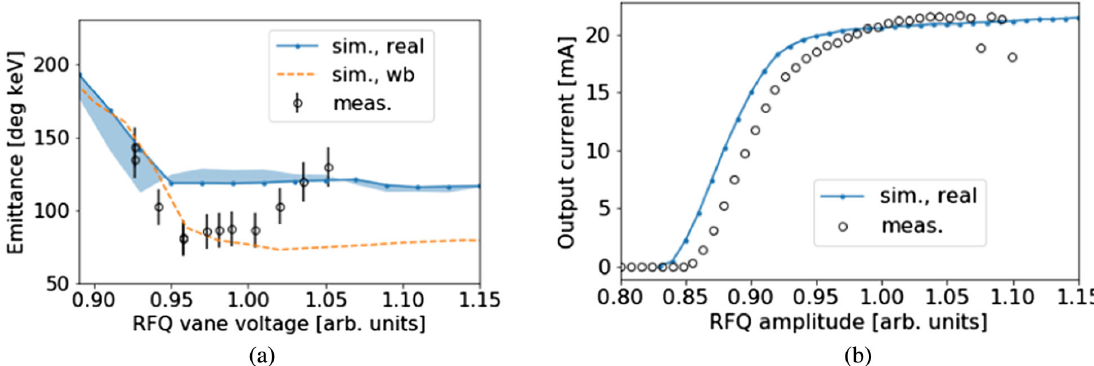
FIG. 11. Dependence of transmission and emittance on RFQ vane voltage. (a) Measured slice emittance compared to fully-projected simulation emittance with 1% thresholds. The shaded region illustrates uncertainty due to LEBT current, with boundaries at 50 mA and 20 mA. The orange dashed curve shows the result for an rms-equivalent, 50 mA waterbag distribution. (b) Measured vs simulated transmitted current. The simulated curve has initial LEBT current 23 mA, adjusted to agree with measured MEBT